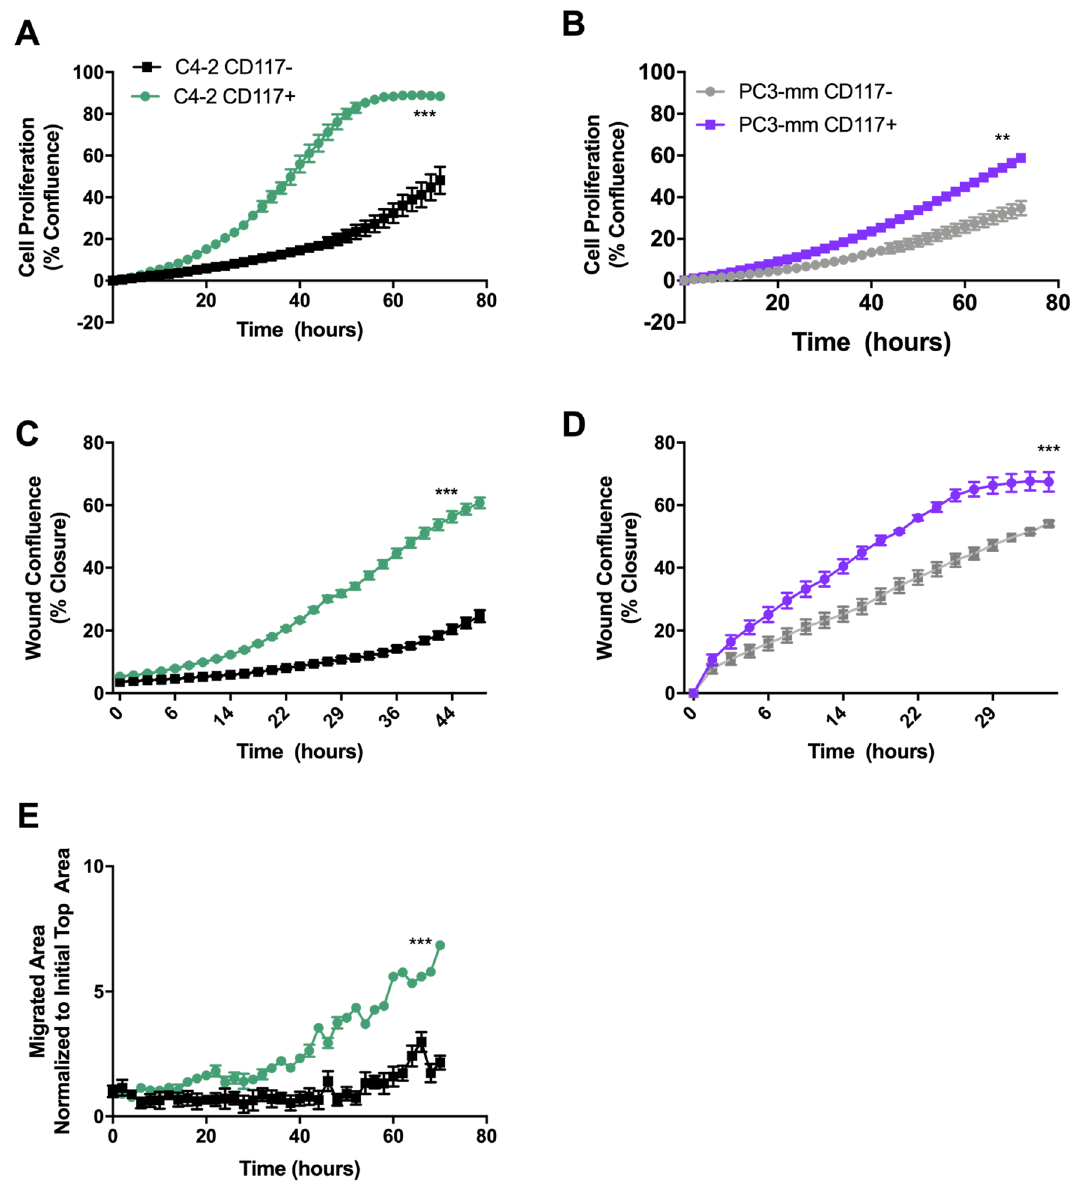
Figure 2. CD117 expression induces cancer cell proliferation and migration. ( A ) C4-2 and ( B ) PC3-mm cells were sorted into CD117+ and negative populations, proliferation measured by live-cell imaging, and represented as mean percent confluence ± SEM ( n = 12). ( C ) C4-2 ( n = 6) and ( D ) PC3-mm ( n = 3) cells were sorted into CD117+ and negative populations. Cell migration was measured by live-cell imaging of a scratch assay. Percent cell confluence in the wound is represented as mean ± SEM. ( E ) Chemotaxis through pores of sorted C4-2 cells as measured by live-cell imaging and represented as number of cells on transwell bottom normalized to initial seeding mean ± SEM ( n = 8). ***Represents p < 0.005 and **represents p < 0.01 by Student’s t